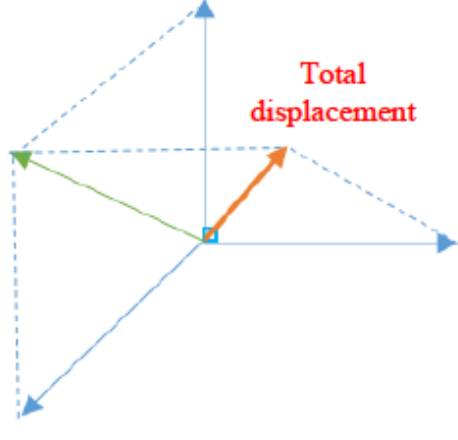
Figure 5: The total displacement of Simultaneous Motion